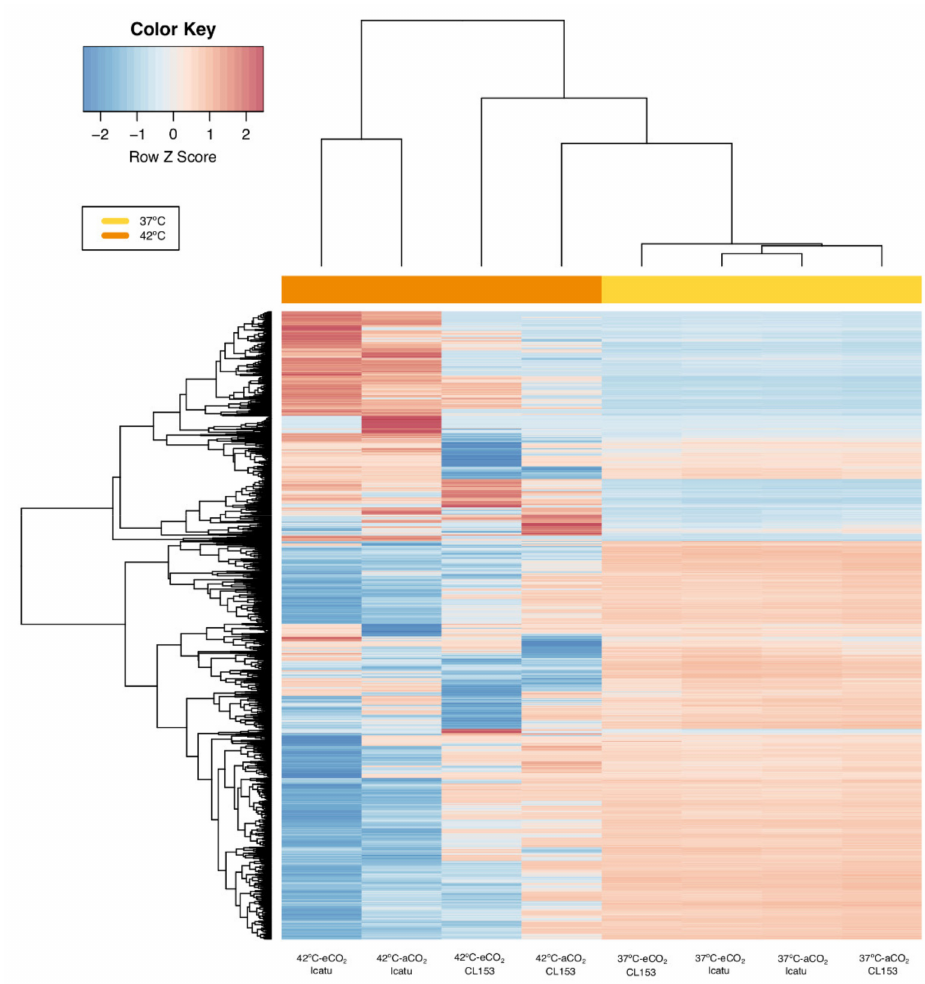
Figure 4. Clustered heat maps and dendrograms of the normalized log 2 fold change visualizing the expression of treatment-specific differentially expressed genes (DEGs) in Icatu and CL153 as a response to 37/28 ◦ C (37 ◦ C) and 42/30 ◦ C (42 ◦ C) temperatures under 380 µ L L − 1 aCO 2 or 700 µ L L − 1 eCO 2 . Significant DEGs were filtered by log 2 fold change (FC) > |2| and the plotted values scaled by row using Z-scores. Hot colors represent up-regulated DEGs and cold colors represent down-regulated DEGs. Column color labels group comparisons by temperature treatments (yellow: 37 ◦ C; orange: 42 ◦